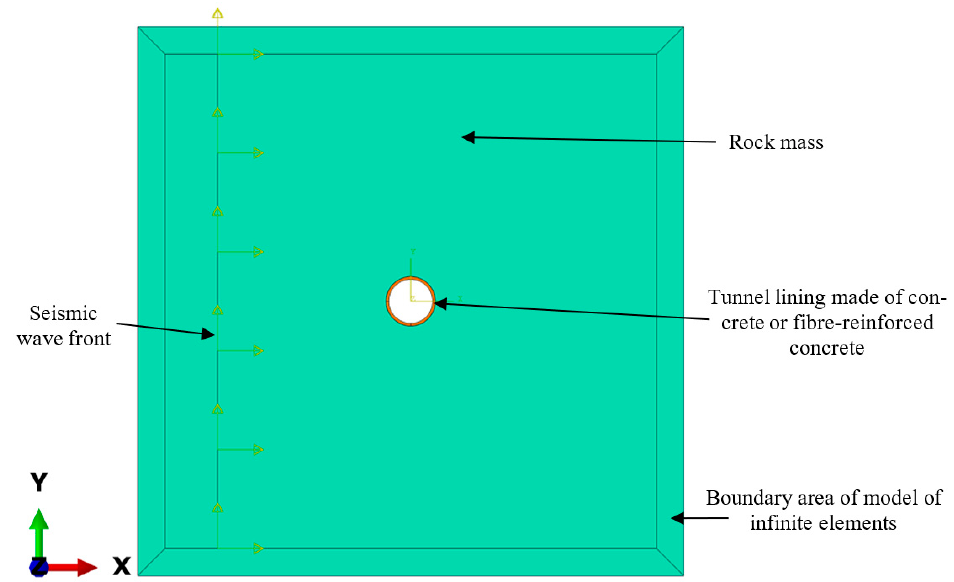
Figure 11. Design scheme of the finite element model.